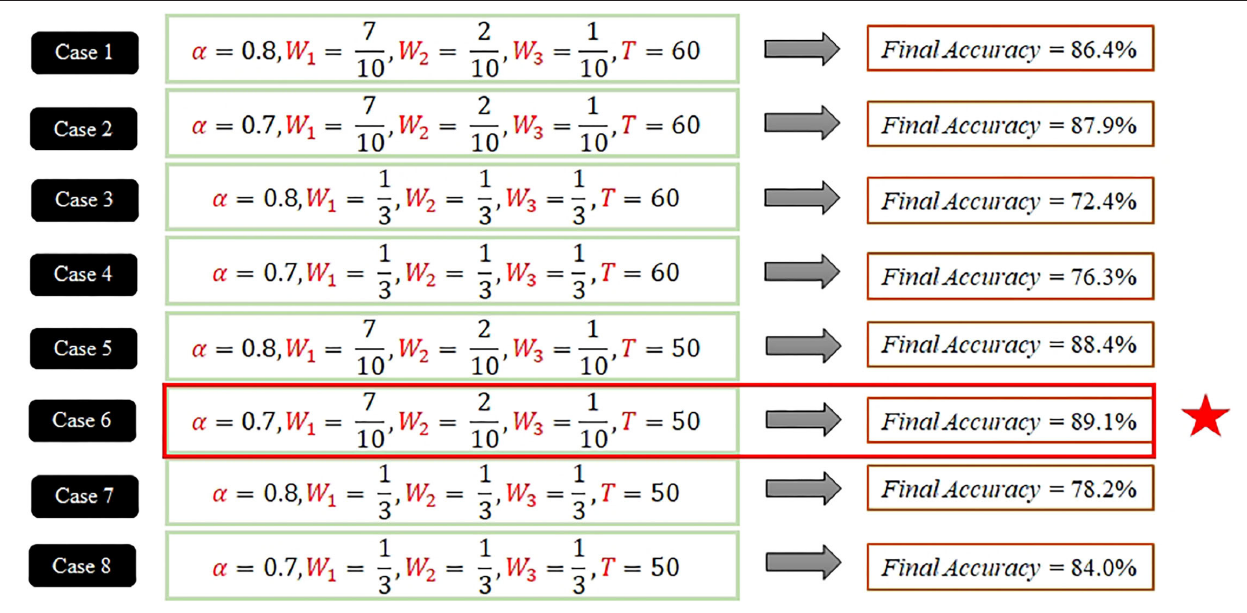
FIGURE 3 | Cross-validation of eight